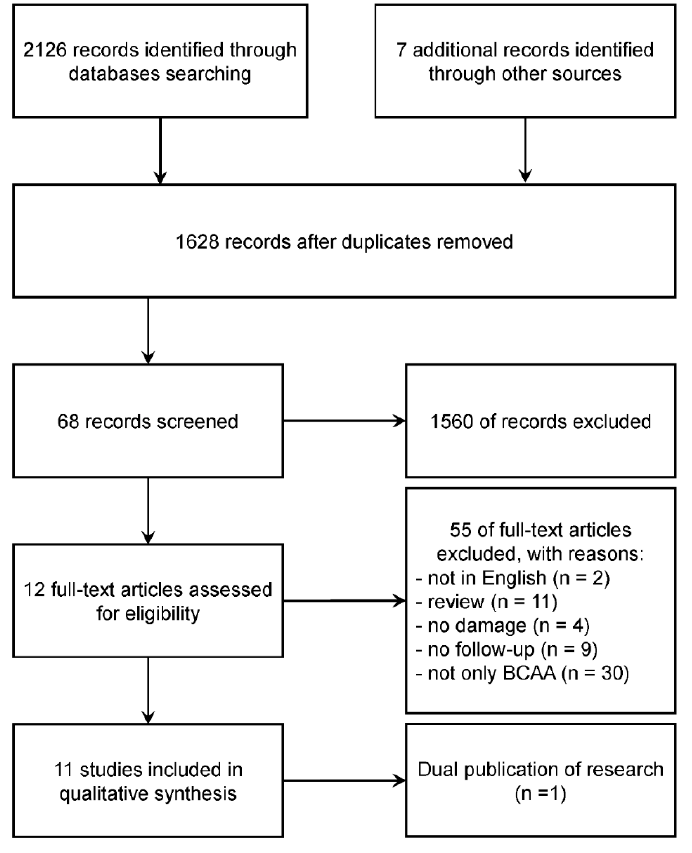
Figure 1. Study selection and flow diagram of articles included in the systematic review.